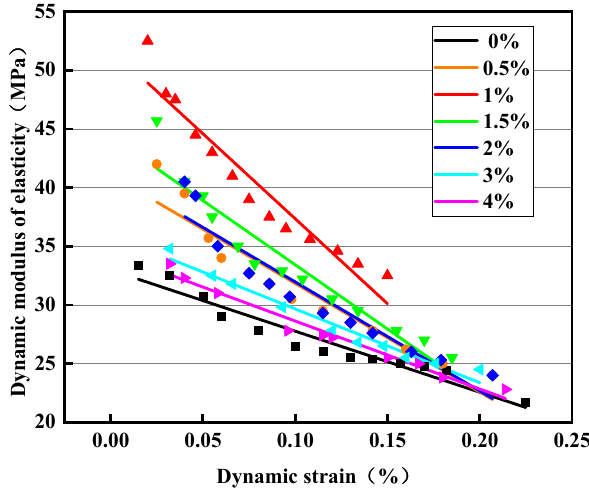
Figure 9. Variation of the dynamic elastic modulus with dynamic strain [47].